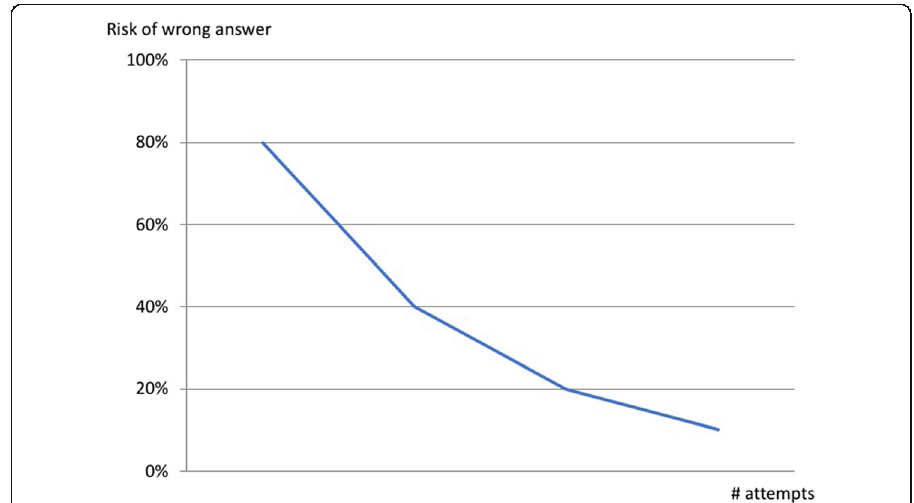
Fig. 1 Theoretical learning curve when instructions, questions and feedback are working